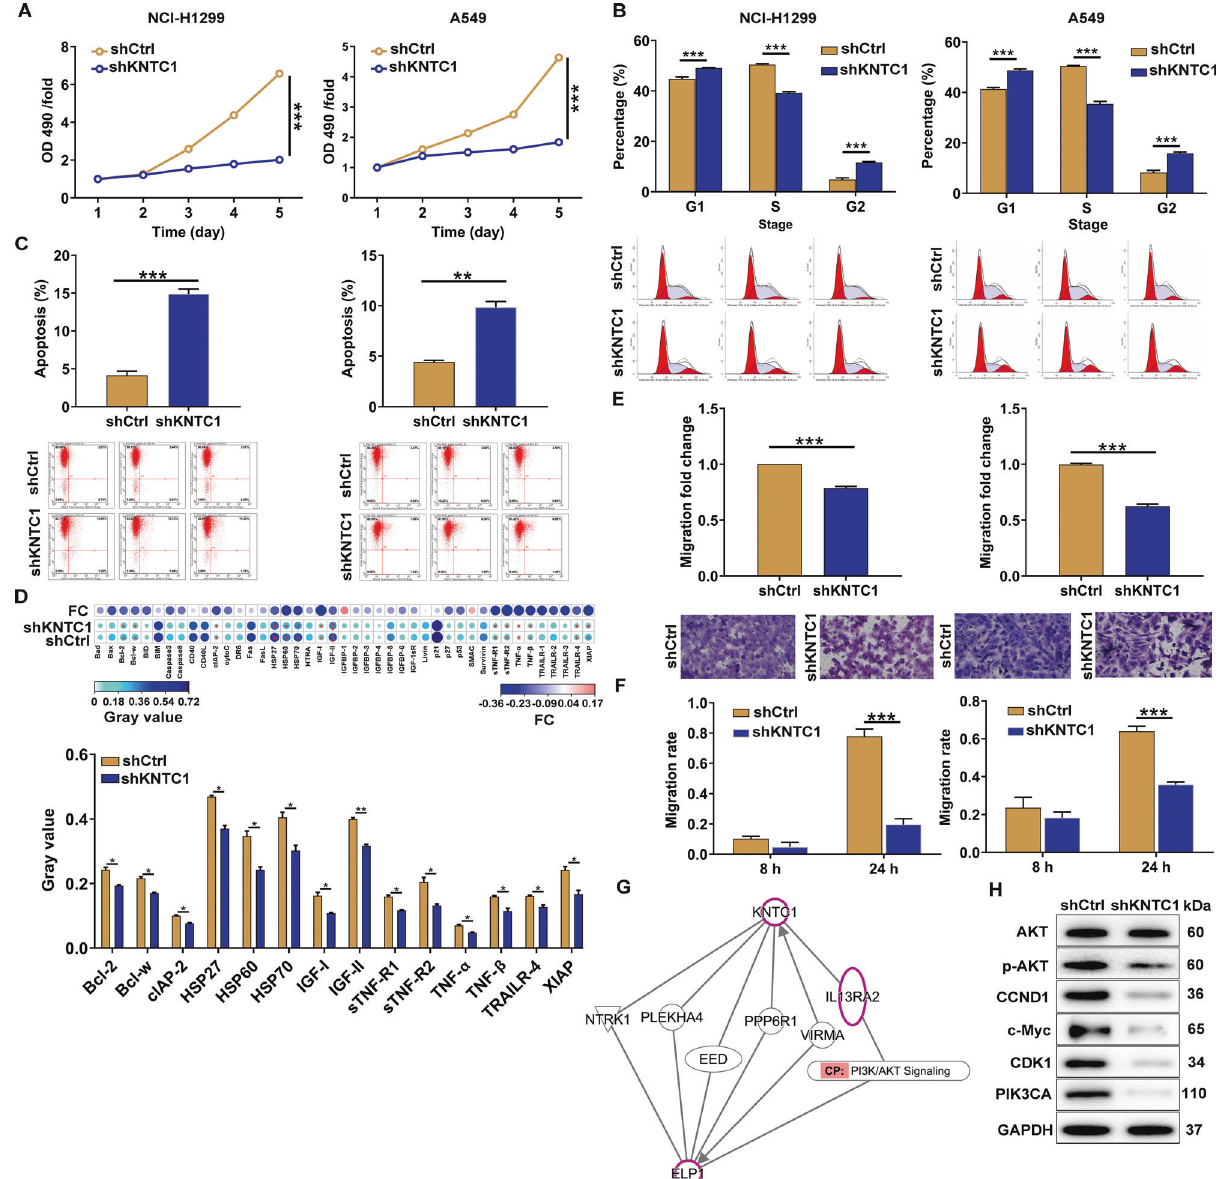
Fig. 2 KNTC1 knockdown inhibited NSCLC development in vitro. A The cell proliferation rate was evaluated in NSCLC cell lines after transfection by MTT assay. B The effects of KNTC1 knockdown on cell cycle were determined by fl ow cytometry. C The effects of KNTC1 knockdown on cell apoptosis were examined by fl ow cytometry. D Human apoptosis antibody array was utilized to illustrate the regulation of the expression of apoptosis-related proteins by KNTC1 knockdown in A549 cells transfected with or without KNTC1. Protein expression was presented in grayscale and visualized by R studio. E The migration rate of cells was detected in NSCLC cell lines after transfection by transwell assay. Magni fi cation times: ×200. F The migration rate of cells was detected in NSCLC cell lines after transfection by wound-healing assay. G The interaction between KNTC1 and AKT pathway was veri fi ed via the IPA analysis. H The expression of some cancer-associated factors was detected by western blot. Results were presented as mean ± SD. * P < 0.05, ** P < 0.01, *** P < 0.001.